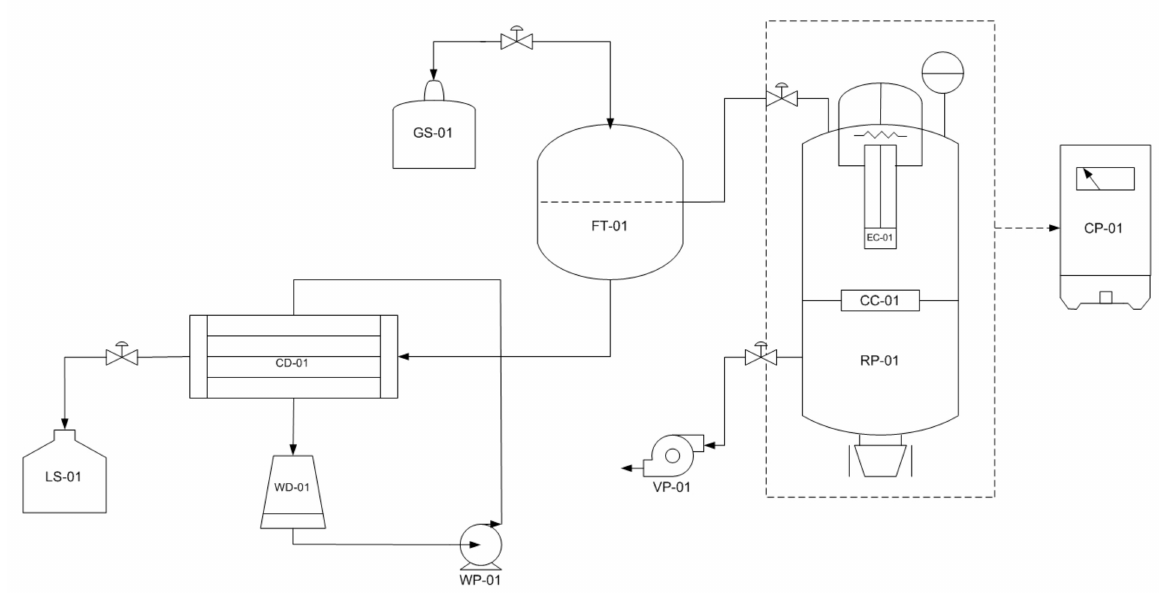
Figure 1. Modified vacuum pyrolysis diagram for converting bagasse to syngas. CC-01: biomass chamber; CP-01: control panel; CD-01: condenser; EC-01: electromagnetic induction source; FT-01: flash tank; GS-01: gas storage; LS-01: liquid storage; RP-01: pyrolysis reactor; VP-01: vacuum pump; WD-01: water drum; and WP-01: centrifugal